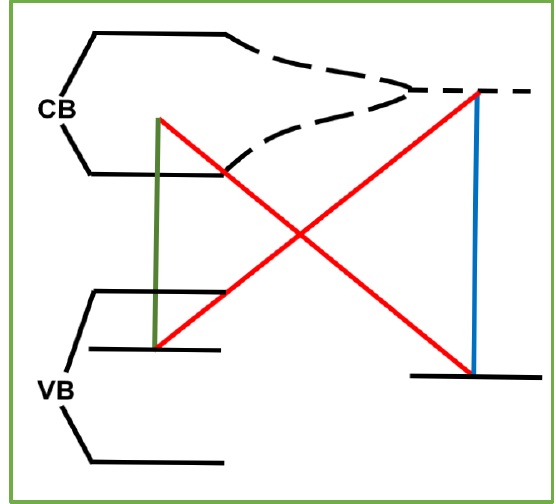
Fig. 7. Bonding-Antibonding Mixings.At zero order, the solid electron basis {  } is composed of a full valence band ( VB) and an empty conduction one ( B). The molecular one has 𝜉𝜉 ∈ a full bonding state: g and an empty antibonding one: u (g= 𝜂𝜂 ∈ C  g (1s) and u=  u *(1s)). By solid-molecule perturbations, four bonding-antibonding mixings are operating and involve excitation energies: (i) interbands:  , purely molecular: , or towards the or charge transfer towards the solid: ε 𝑔𝑔𝑔𝑔 , 𝜀𝜀 𝜉𝜉 . (The molecular bonding energy: lies deeper molecule ε 𝑔𝑔𝜂𝜂 - 15,8 eV). The dashed curve represents than represented, 𝜀𝜀 𝑔𝑔 ε 𝜉𝜉𝑔𝑔 the “dressing” of the molecular antibonding u state by the 𝜀𝜀 𝑔𝑔 ≈ conduction